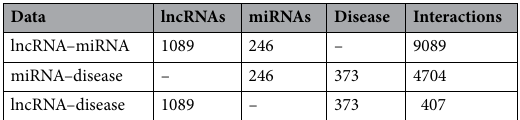
Table 1. Experimental data